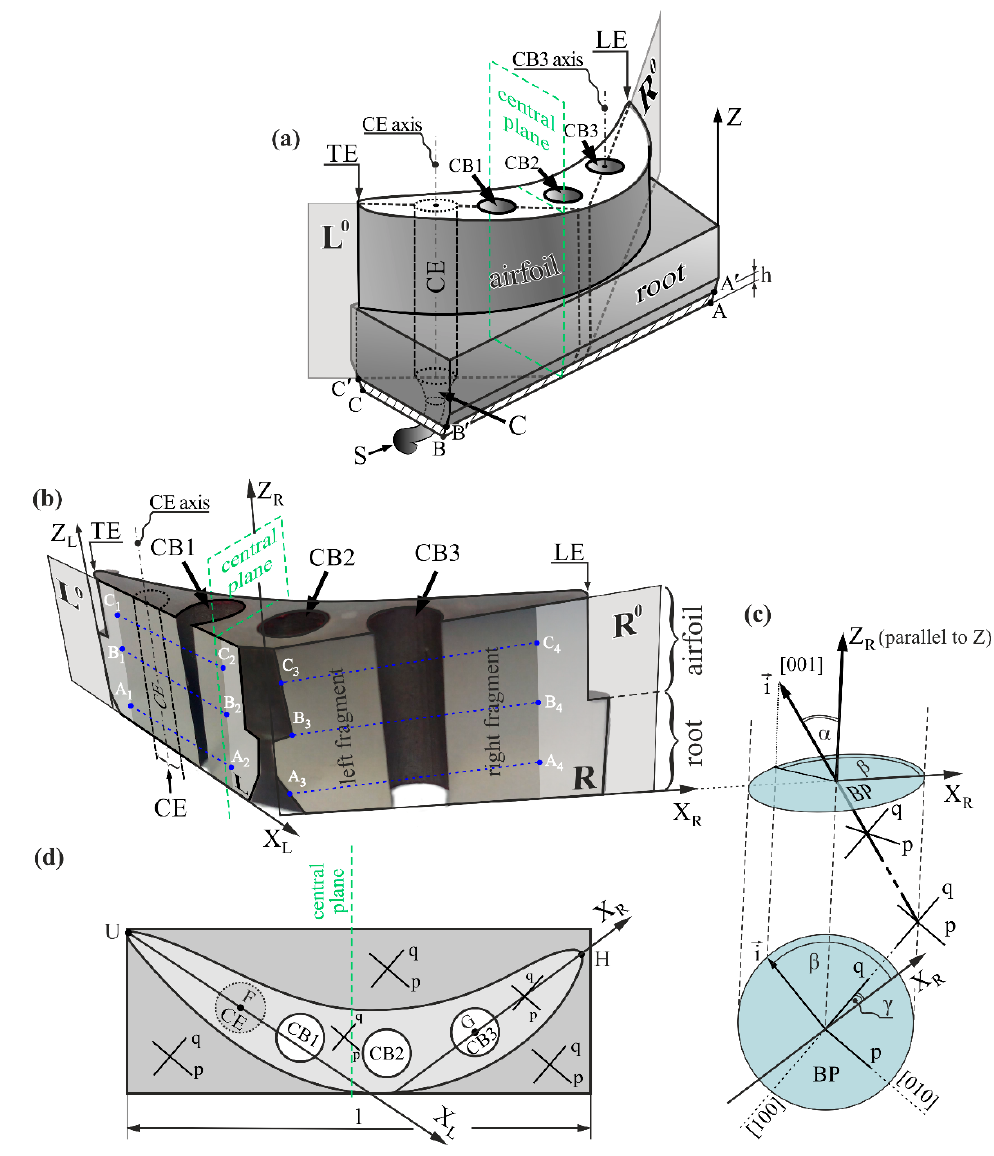
Figure 1. Schema of the blade with the location of the cutting planes L 0 and R 0 ( a ); the shape of the sample with two lateral surfaces L and R ( b ); the graphical definition of the primary crystal orientation angular components α and β and the secondary crystal orientation angular component γ ( c ); and top view of the blade with the schema of the secondary dendrite arm orientation ( d ). Z—blade axis, perpendicular to the surface ABC of the root; CB1, CB2, CB3—cooling bores; S—selector; C— continuer; CE—continuer extension area; h—bottom root layer of the unsteady dendrite growth; LE and TE—leading and trailing edge of the airfoil; BP—base plane parallel to the ABC surface and perpendicular to Z; 𝚤⃗ —unit vector. The α angle is enlarged for figure clarity; p and q define the alignment of the secondary dendrite arms.